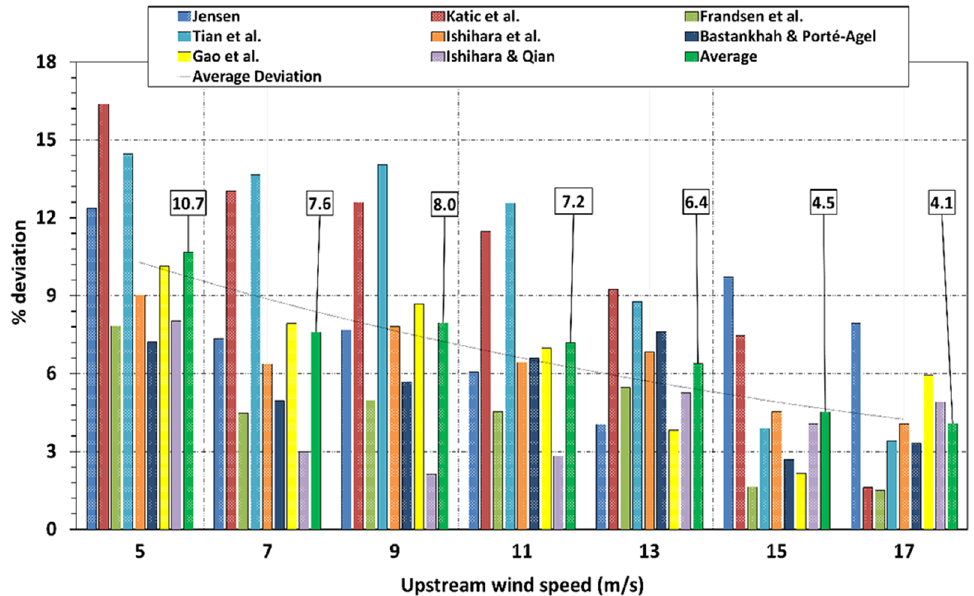
Fig. 13. Percentage deviation per wake model and upstream wind speed in the entire far-wake region. Note: The green column (with the data labels) depicts the average percentage deviation of all wake models